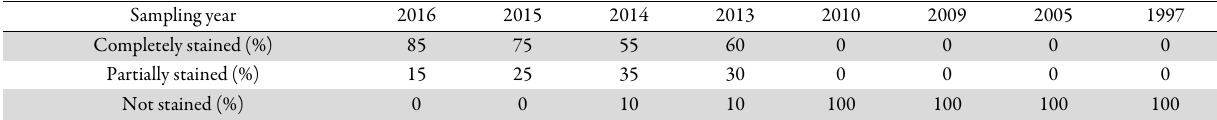
Fig. 5. Germination kinetics of seeds of the selected species, collected in 2016, during four weeks following sowing in a substrate of 50% peat, 25% perlite, and 25% Table 4.Viability of T. maritimum seeds tested by tetrazolium staining. Seeds completely stained are considered as ‘viable’